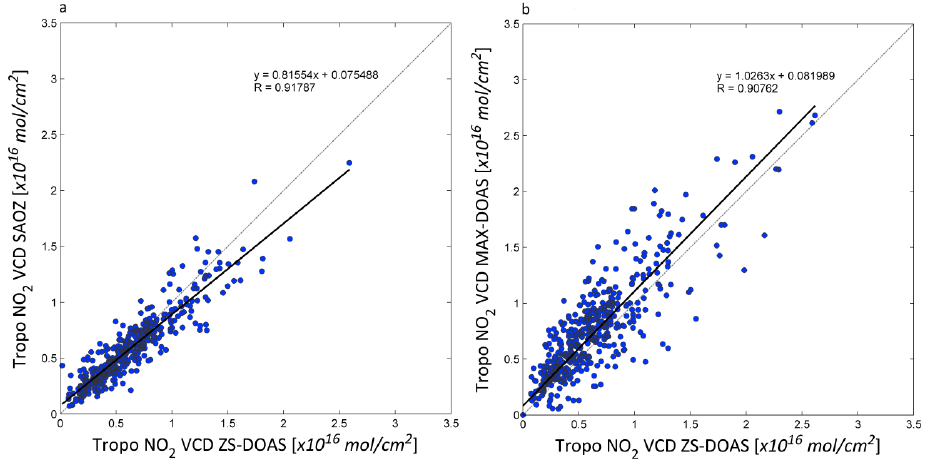
Figure 7. Scatter plot and linear regression analysis of the TVCDs retrieved for the whole time series from (a) ZS-DOAS and SAOZ, and (b) ZS-DOAS and MAX-DOAS, respectively. TVCDs are binned and averaged in 30min bins.